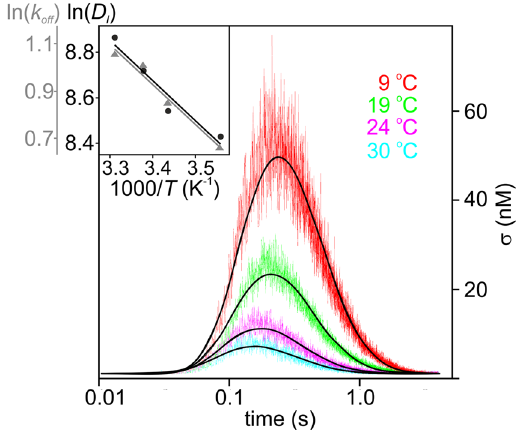
Figure 3. Kinetics of the proton concentration adjacent to the membrane surface at 80 µ m from the release spot for different temperatures. The colored traces are averaged data from at least 10 individual release events each. At least three such averaged traces had been obtained at every temperature for four distances: 80, 90, 100 and 110 µ m. The global fits of the non-equilibrium model (equation (S3)) to all traces at a given temperature is depicted as solid black lines. Inset: Temperature dependencies of the rate coefficient for proton surface- to-bulk release ( k off , in units of s − 1 ) and for the lateral diffusion constant ( D l , in units µ m 2 s − 1 ). The slopes correspond to Δ H ‡ l ≈ 5.9 ± 1.1 k B T and Δ H ‡ r ≈ 5.7 ± 0.7 k B T , whereas the intercepts with the y-axis are A l = (3.3 ± 0.5) × 10 6 µ m 2 s − 1 and A r = (8.1 ± 0.9) × 10 2 s − 1 , respectively (compare equations (7) and